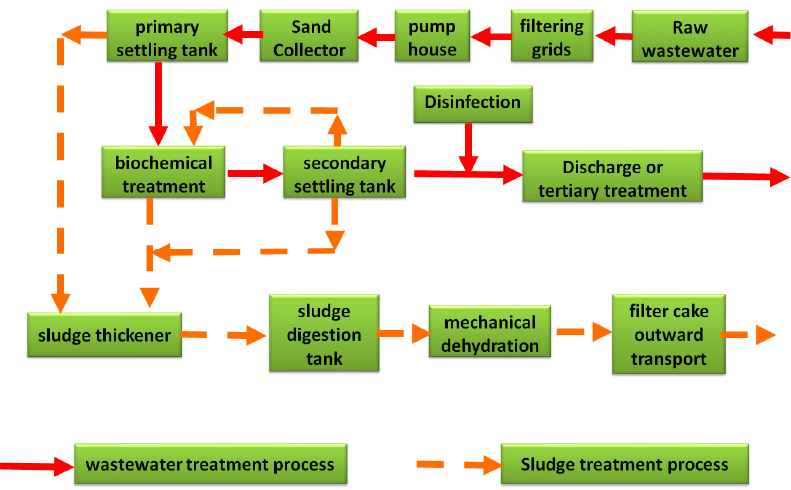
Figure 1. Typical process flow diagram of a wastewater treatment plant (WWTP).